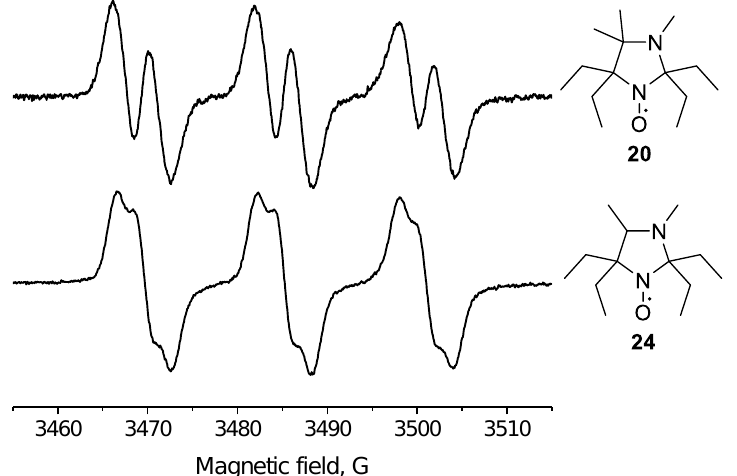
Figure 3. EPR spectra of nitroxides 20 and 24 .